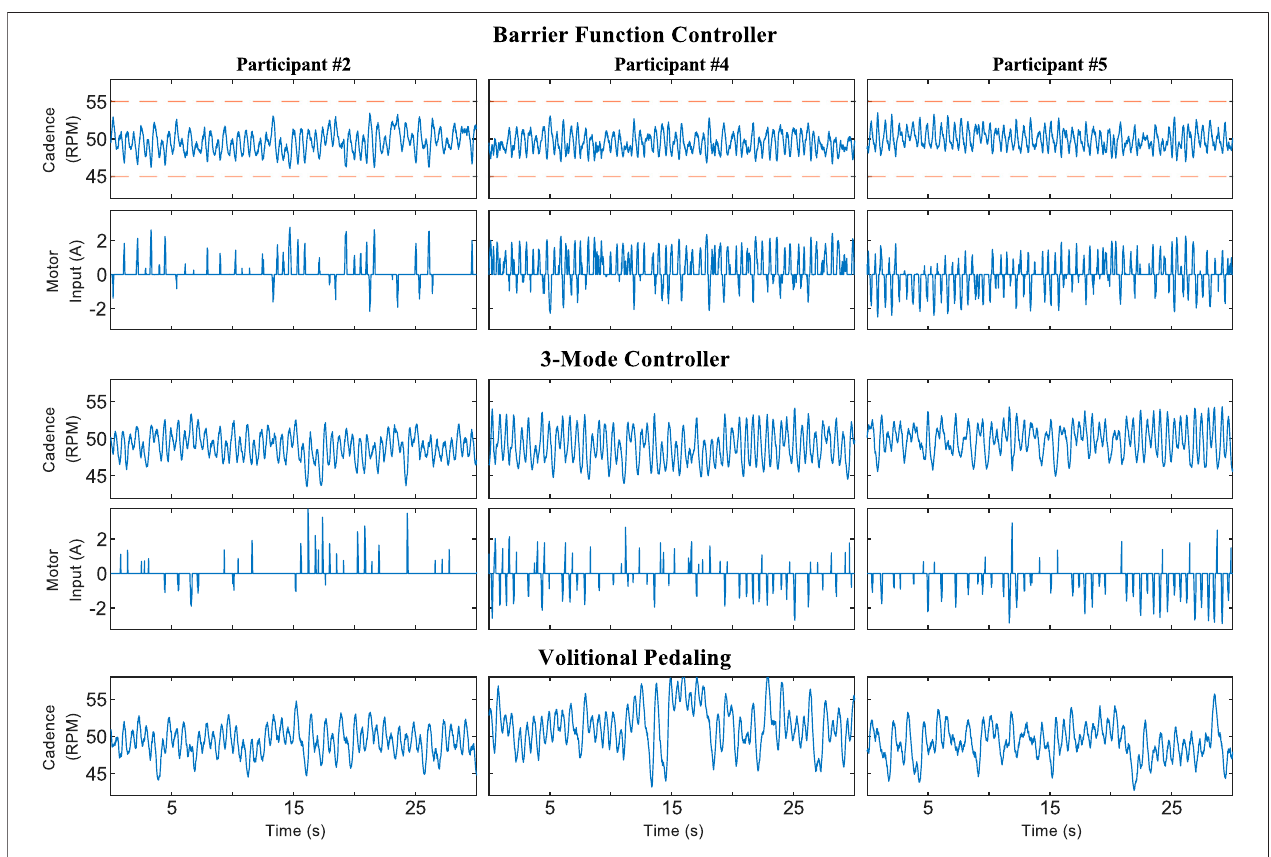
FIGURE 3 | Zoomed view of a 5-s time period during a trial using Protocol A showing the cadence, motor control input, and stimulation pulse-width (PW) for Participant 5. Random selection was used to choose which participant and time period were plotted. The time axis is offset to zero for readability. A pulse-width feedforward term of 10 μ s was used to facilitate stimulation. The stimulation does not signi fi cantly affect the participant at or below 10 μ s.